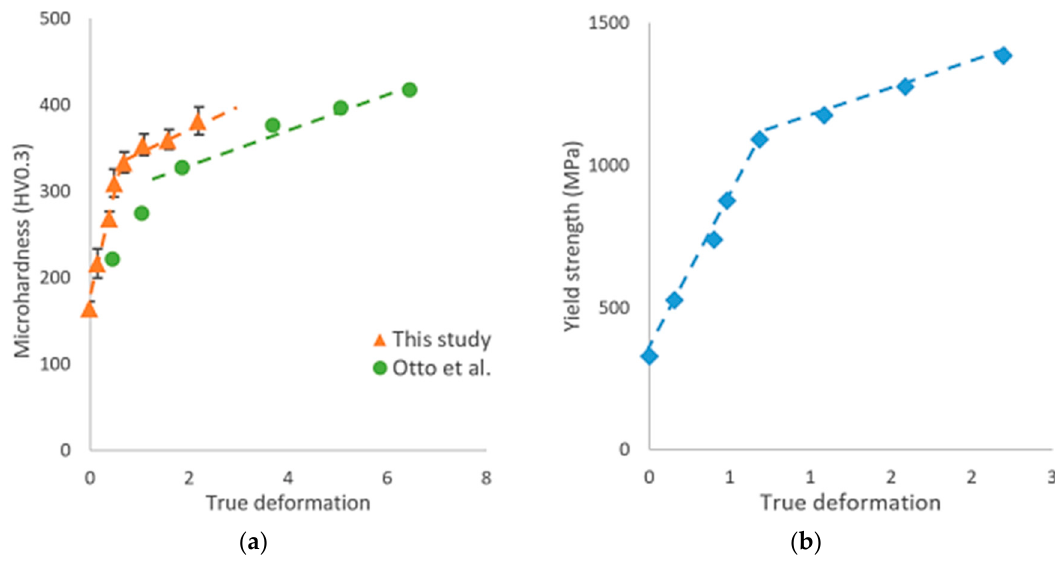
Figure 3. ( a ) Microhardness Vickers (HV 0.3 ) evolution with the surface reduction, for this study (orange triangle) and comparison with results published by Otto et al. [15] (green dot), ( b ) yield strength evolution during grooved cold rolling process.